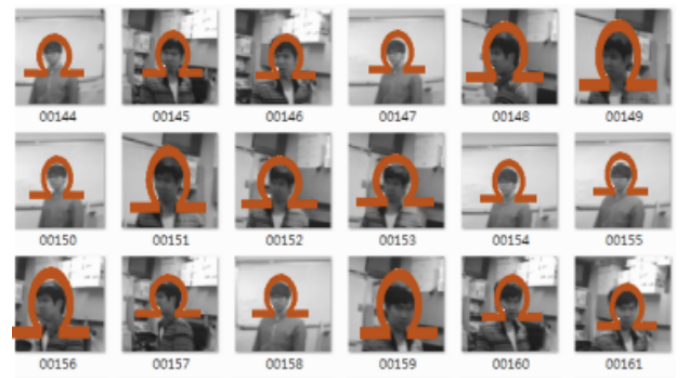
Figure 4. Example of human head-shoulder